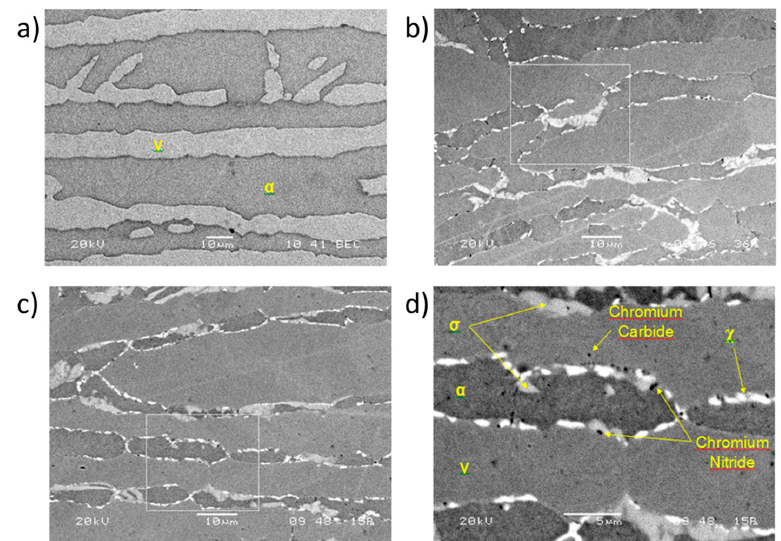
Figure 2. SEM images using backscattered electrons for the untreated sample (as received, S1) ( a ); sample aged for a period of time of 21 min (S2) ( b ); sample aged for a period of time of 25 min (S3) ( c ); and a zoom of the region of interest of S3 for a better appreciation of the secondary phases in the austenite/ferrite matrix ( d ). The white rectangles mark the zone where the zoom is performed. Table 3. EDX analysis showing the evolution of the chemical composition of the sigma phase as a function of the time thermal treatment from 21 min to 25 min (wt %).